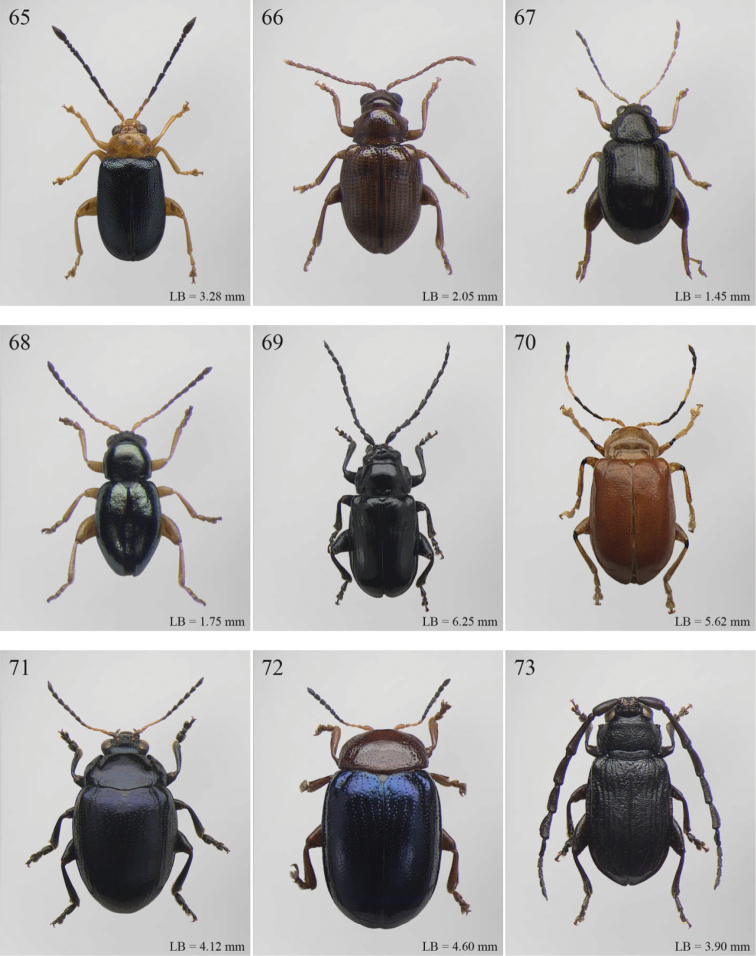
Habitus. 65
Malvernia varicornis Jacoby 66
Manobia africana Laboissière 67
Metroserrapha sp 68
Montiaphthona gedyei (Bryant) 69
Myrcina vandenplaasi Laboissière 70
Neodera fraterna Duvivier 71
Nisotra aruwimiana Weise 72
Notomela fulvicollis Bryant 73
Ntaolaltica antennata Biondi & D’Alessandro.